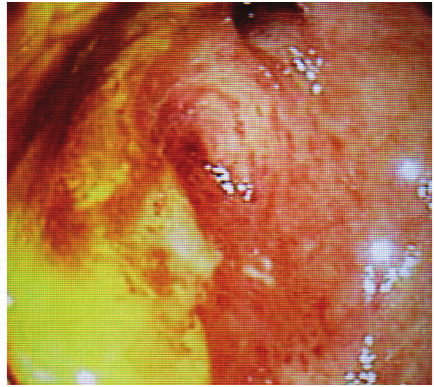
Figure 2: Mucosal edema with friability and ulceration on colonoscopy.